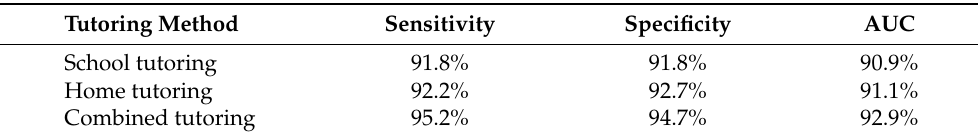
Table 2. Performance of deep SVM without using improved